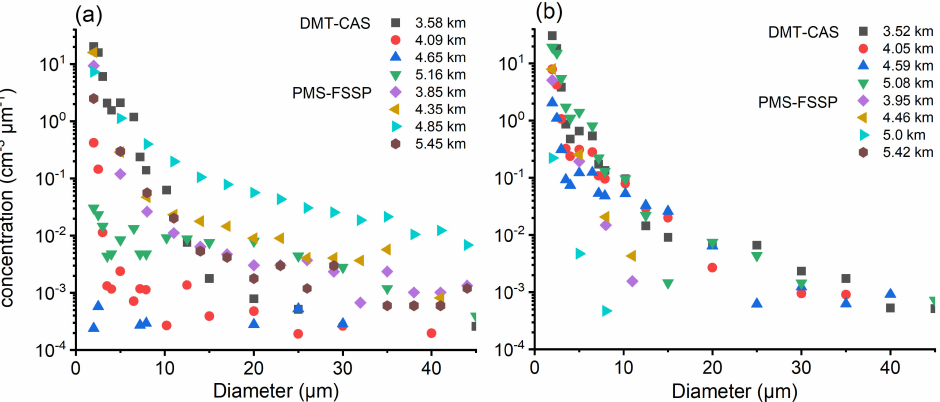
Figure 5. PSD (2–45 µ m) detected by FF: ( a ) PMS-FSSP (3.85, 4.35, 4.85, 5.45 km), DMT-CAS (3.58, 4.09, 4.65, 5.16 km), SF: ( b ) PMS-FSSP (3.95, 4.46, 5.0, 5.42 km), DMT-CAS (3.52, 4.05, 4.59, 5.08 km).